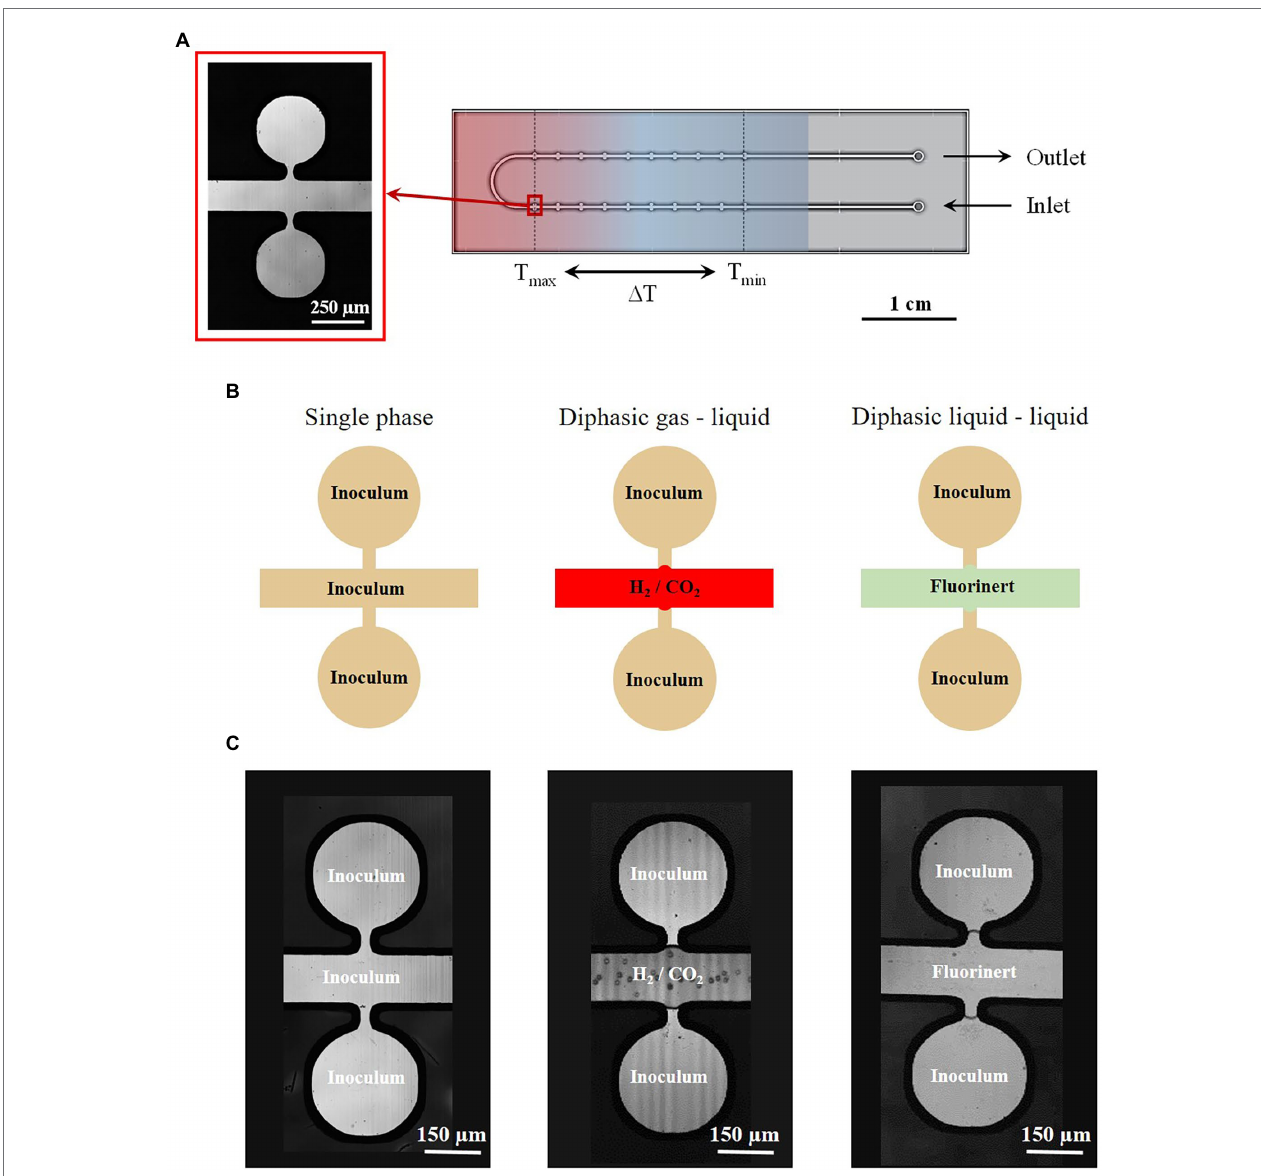
FIGURE 1 | (A) Design of the temperature-gradient microreactor developed and used in this study with a microscope picture of the micropools used for both Thermococcus barophilus and Methanothermococcus thermolithotrophicus cultivation. (B) Different feeding strategies implemented into the microfluidic setup using growth medium phases and several interfaces. (C) Pictures of the concerning cultivation interfaces into the